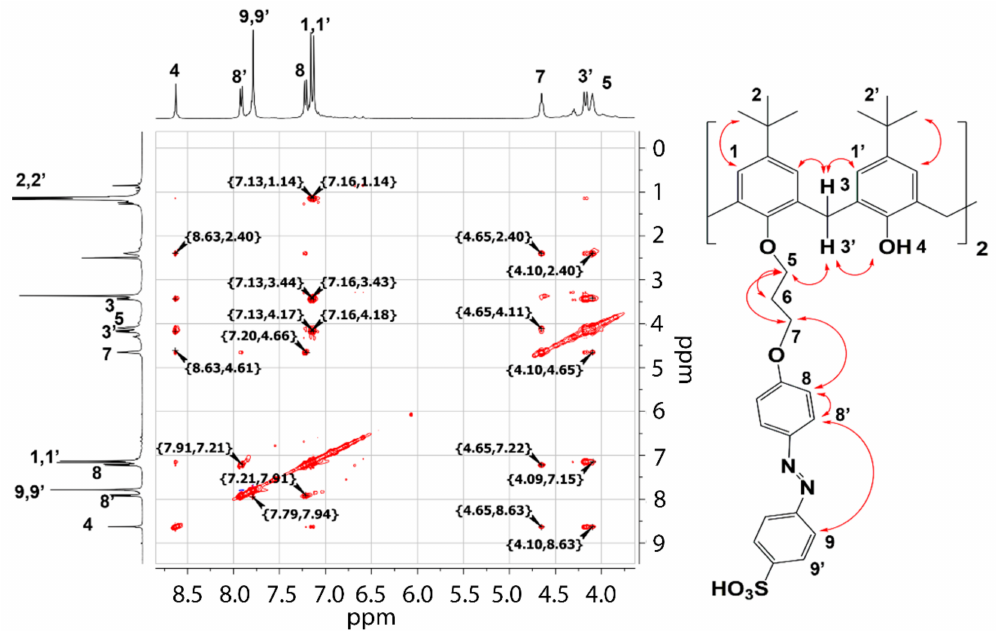
Figure 1. A fragment of 2D NOESY 1 H- 1 H spectra of 4 , DMSO-d6, 25 ◦ C. In the HRESI mass spectra (Figure S1), in negative mode, the main peaks correspond to [M-2H] 2 − with m / z = 641.2691 (calculated for C 74 H 82 N 4 O 12 S 22 − = 641.2691), [M-H] 1 − with m / z = 1283.5449 (calculated for C 74 H 83 N 4 O 12 S 2 − = 1283.5454) and [M-2H + Na] 1 − with m / z = 1305.5307 (calculated for C 74 H 82 N 4 NaO 12 S 22 = 1305.5274). To create hypoxia- sensitive systems, the next step was the study of double azo calixarene-dye systems. Considering that all macrocycles contain negatively charged sulfonic or carboxylate groups, the most widespread xantene cationic dyes, namely rhodamines 6G, 123 and B, were used (Rh6G, Rh123 and RhB, Scheme